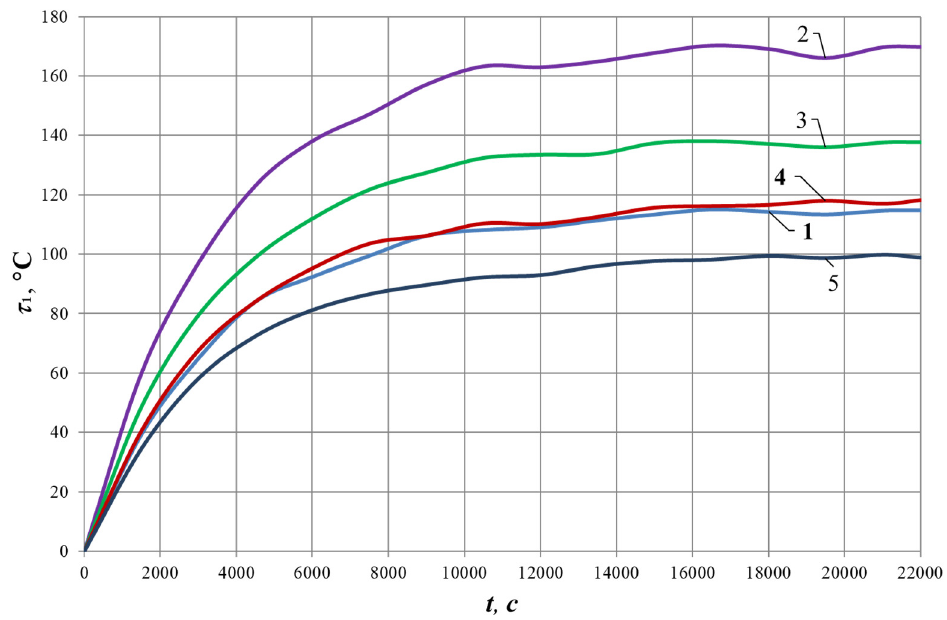
Figure 9. Dependence τ = f ( t ) at different values of k l and k u .